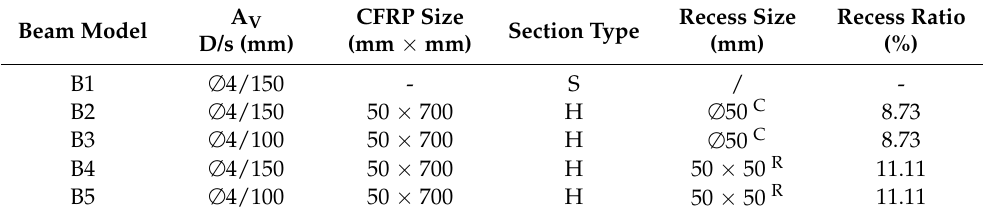
Table 1. Characteristics of the numerical beam models. Adapted from Ref. [23]. Beam Model